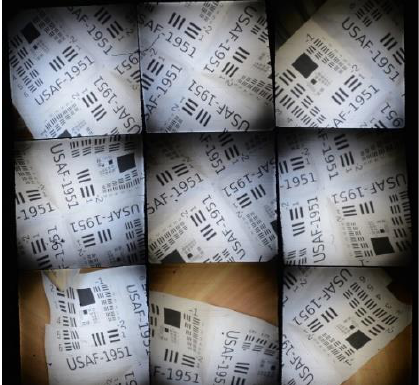
Figure 3. Image captured by compound-eye system.